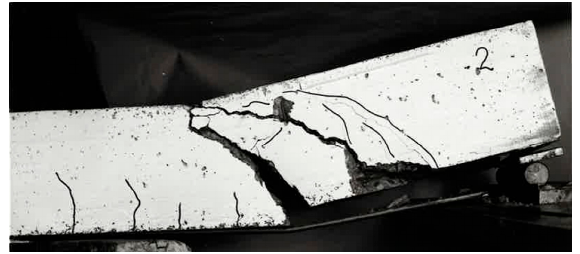
Figure 16. Failure mode in the static loading test on Beam 2B.